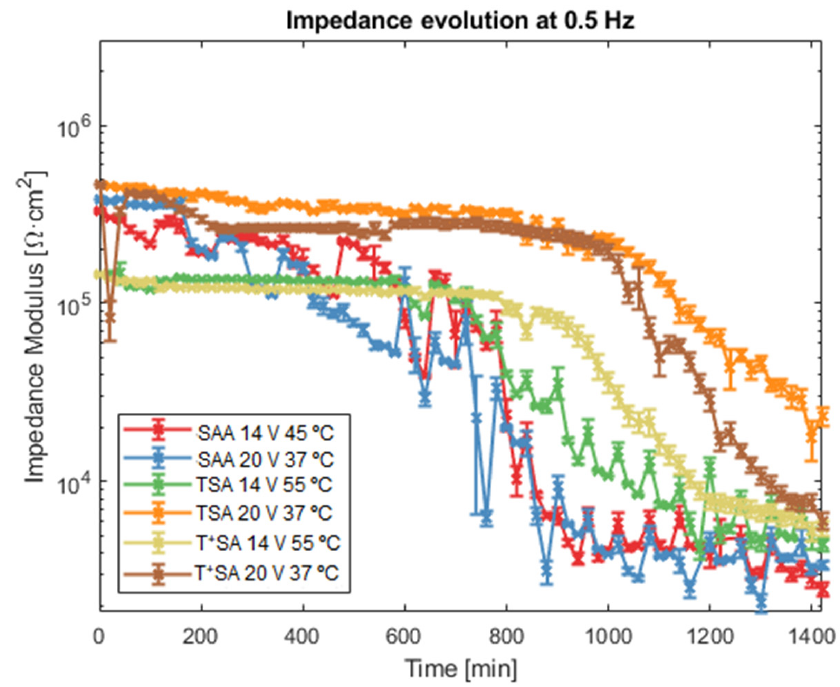
Figure 11. Evolution of the impedance of bare anodic oxide films at 0.5 Hz of different with immersion time in an acidified (pH 3) dilute Harrison’s solution. Error bars represent the addition of stochastic noise and non-stationarities.